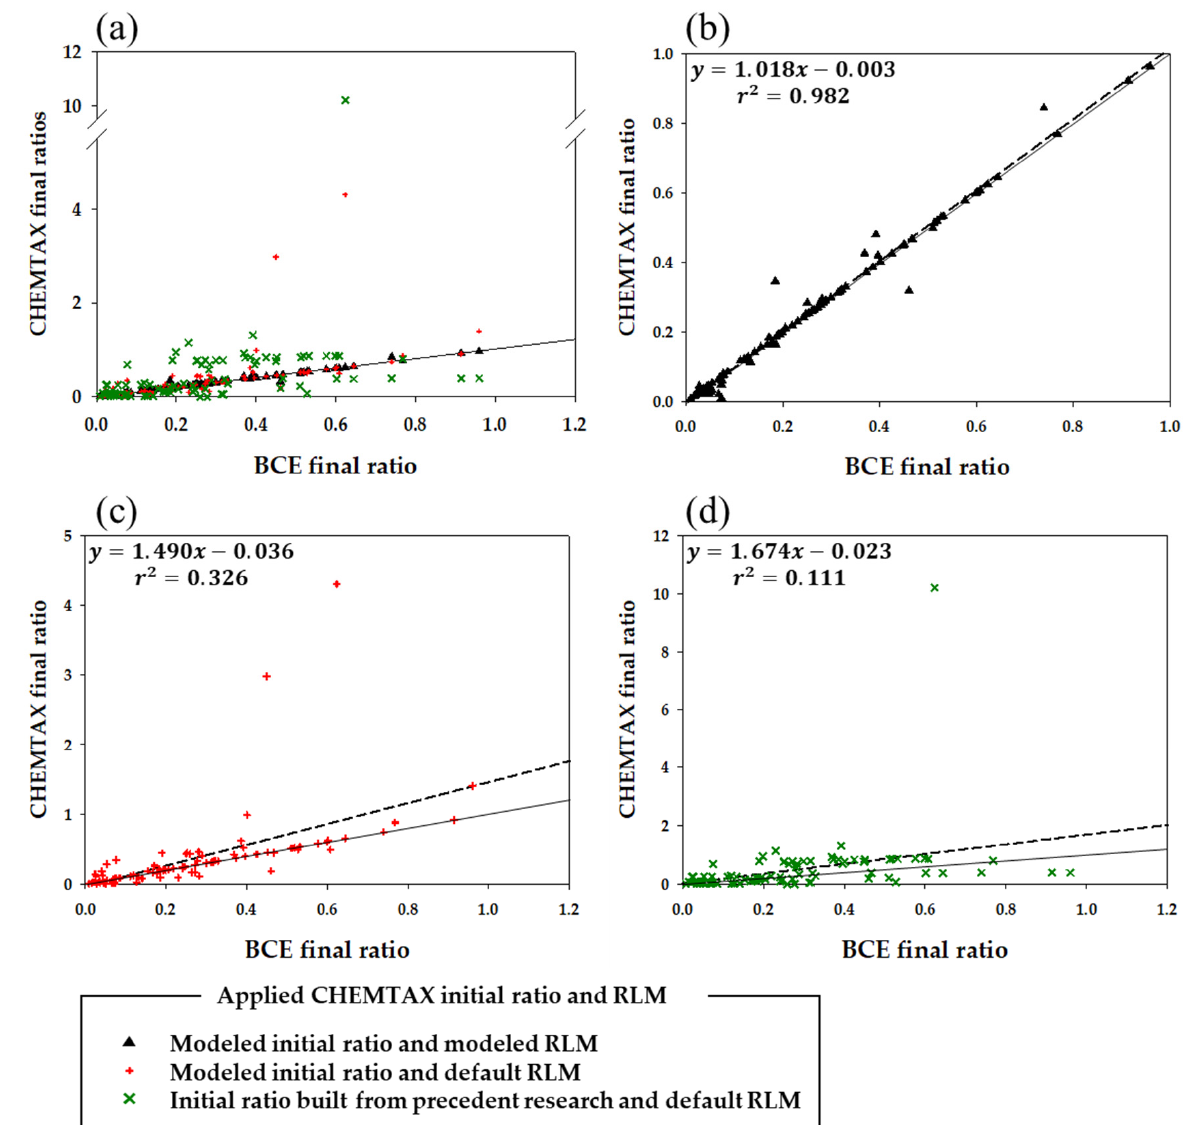
Figure 3. Regression analysis of ( a ) all BCE and CHEMTAX final ratios and those obtained using ( b ) modeled initial ratios and ratio limits, ( c ) modeled initial ratios with default ratio limits, and ( d ) initial ratios built from precedent research [27] (Table 2) with default ratio limits. Dashed and solid lines are regression and 1:1 lines, respectively.